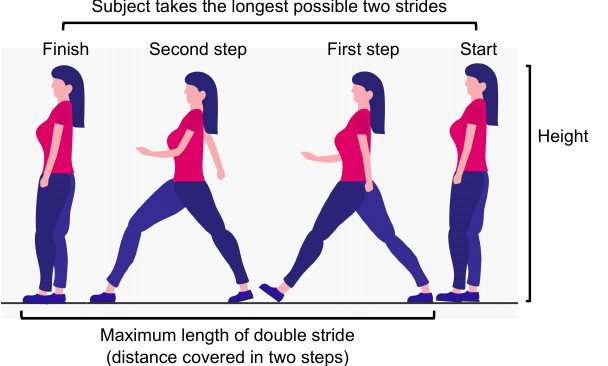
Figure 4. Details of the two-step test in the form of illustrations [7]. This test is used to measure the stride length, which is divided by the subject’s height in order to obtain the final score. This test helps to assess walking ability, muscular strength, balance, gait speed, and lower limb